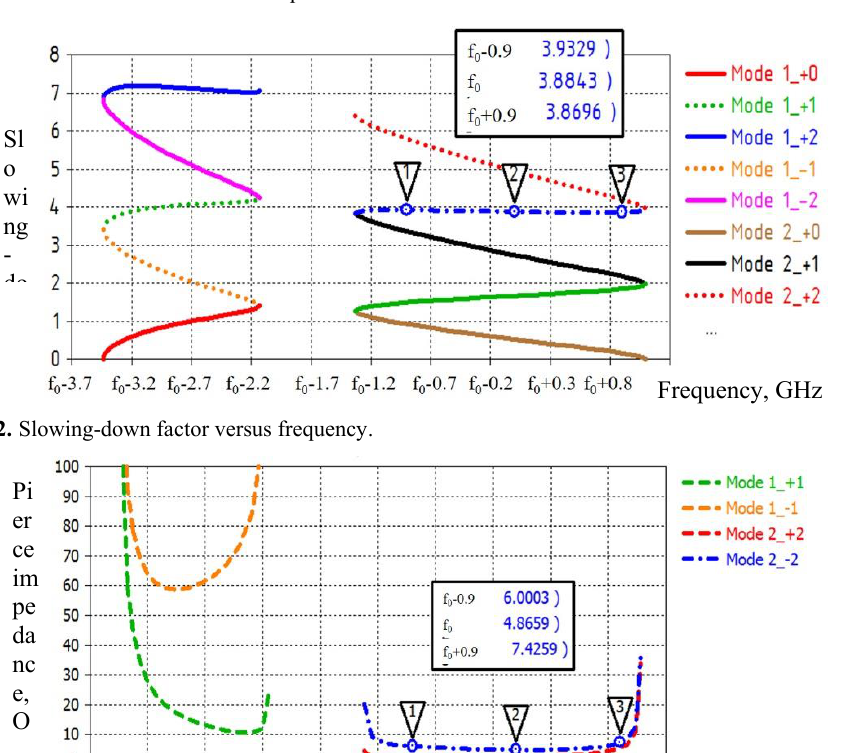
Fig. 1. A model of modernized SWS period.